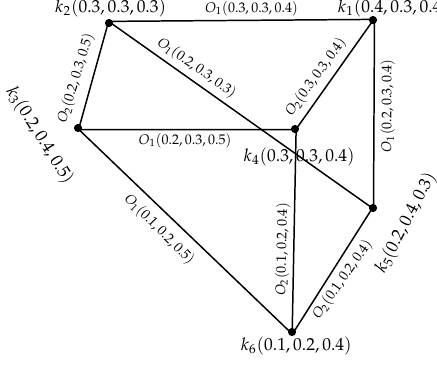
Figure 5. A strong